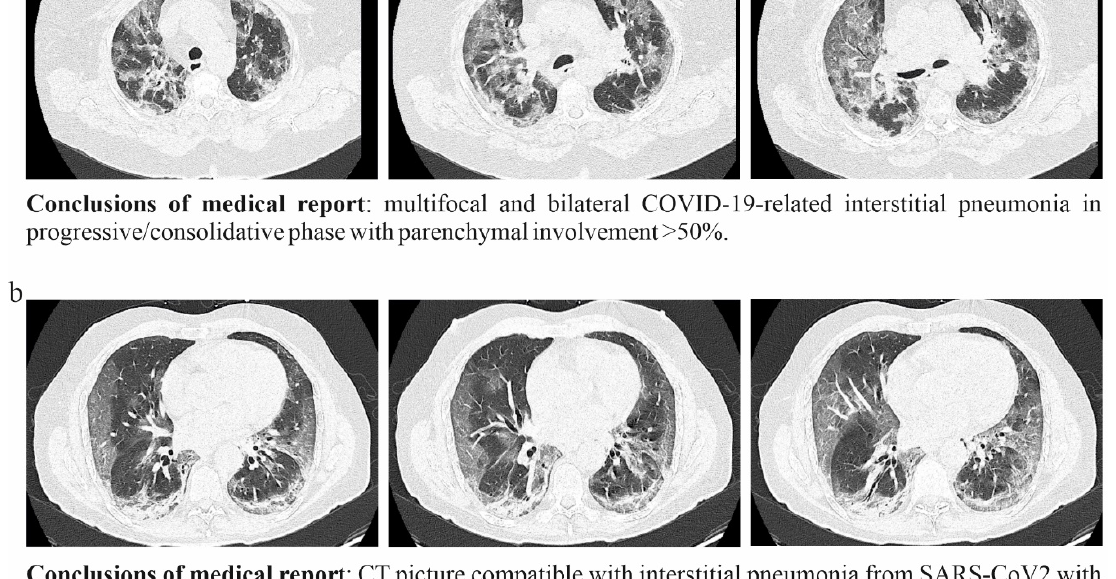
Figure 5. CT lung scan pictures of two randomly chosen COVID-19 patients ( a , b ) enrolled in the study.